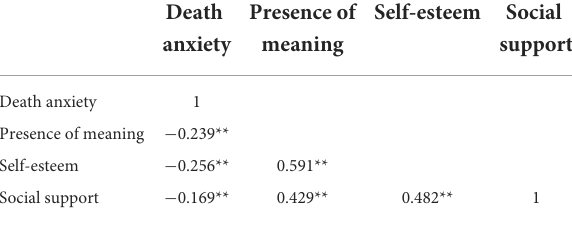
TABLE 2 Pearson’s correlation matrix for death anxiety, social support, presence of meaning, and self-esteem ( N =